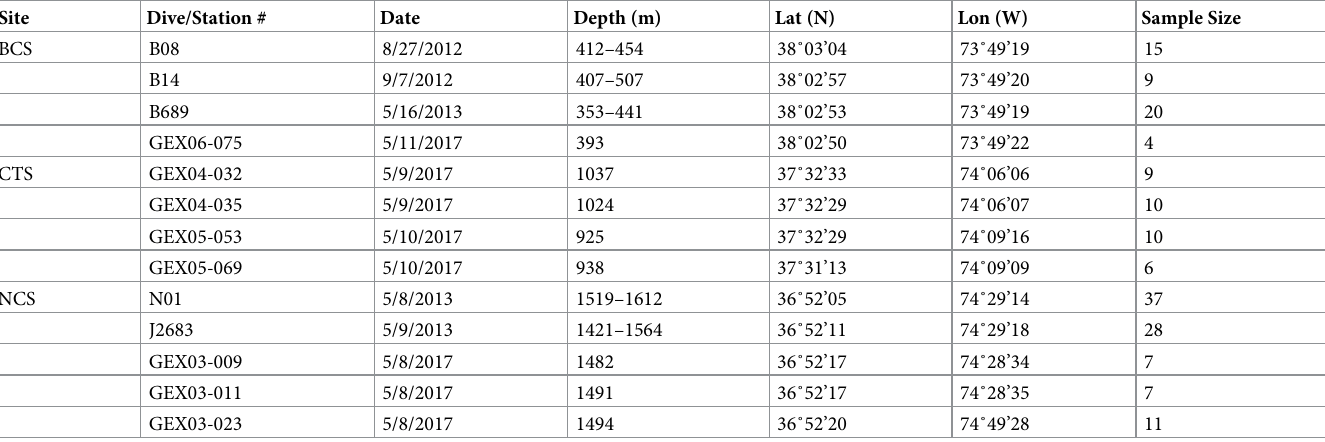
BCS = Baltimore Canyon Seep, NCS = Norfolk Canyon Seep, CTS = Chincoteague Seep. Latitudes (lat (N)), longitudes (lon (W)), and depth ranges from years 2012– 2013 are from